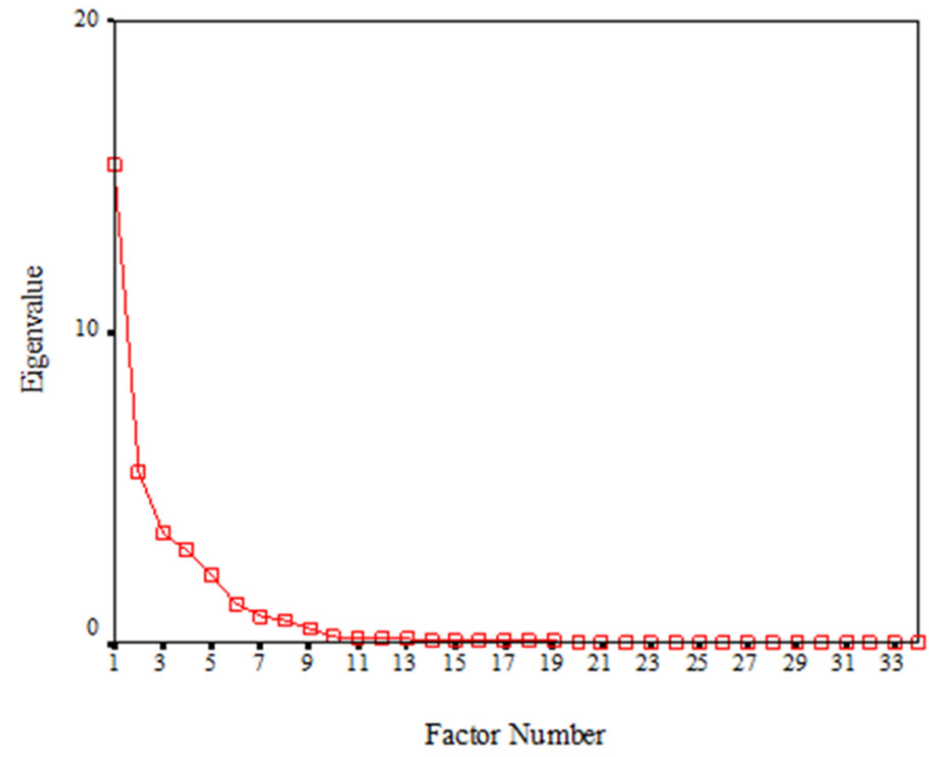
Figure 6. Scree plot, before rotation, for factor extraction of mandibular lateral incisor size variables in the supernumerary group. Table 4. Total and percent variance of the first six factors for mandibular lateral incisor size variables in the supernumerary group. Note: The ‘‘Rotation Sums of Squared Loadings’’ shows factor variance after rotation (Varimax) which was used to transform the initial matrix into one that is easier to interpret.